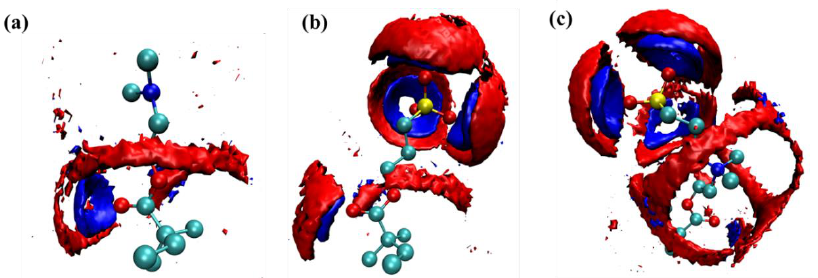
Figure 11. Spatial distribution function of water molecules around three different antifouling monomers. ( a ) DM, ( b ) SP, ( c ) SB.